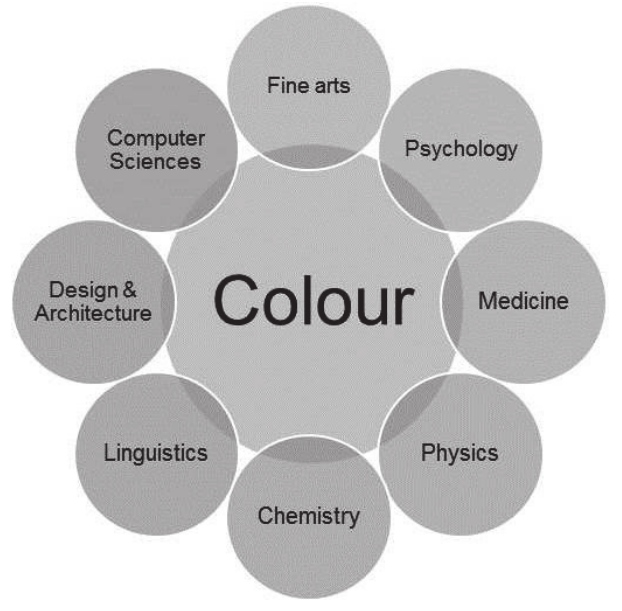
Figure 1. Color as a topic of interest to many research fields.